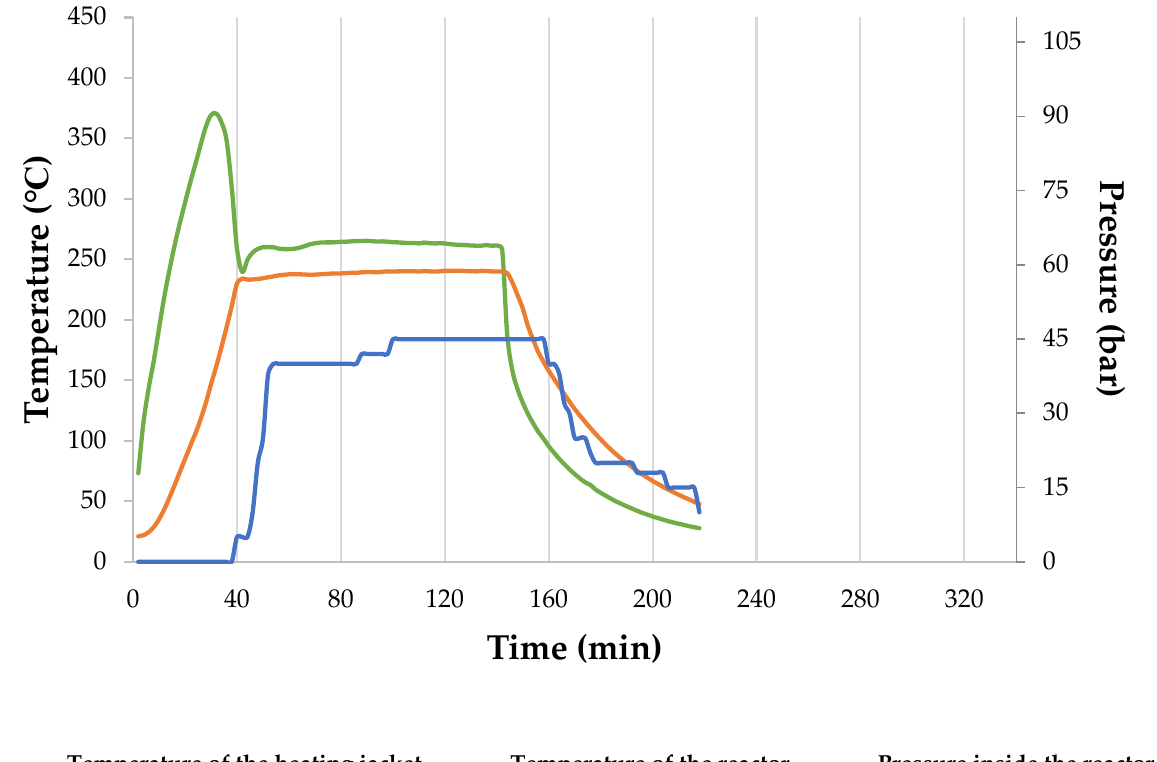
Figure A5. Temperature and pressure patterns during the process at 240 ◦ C in 90 min.